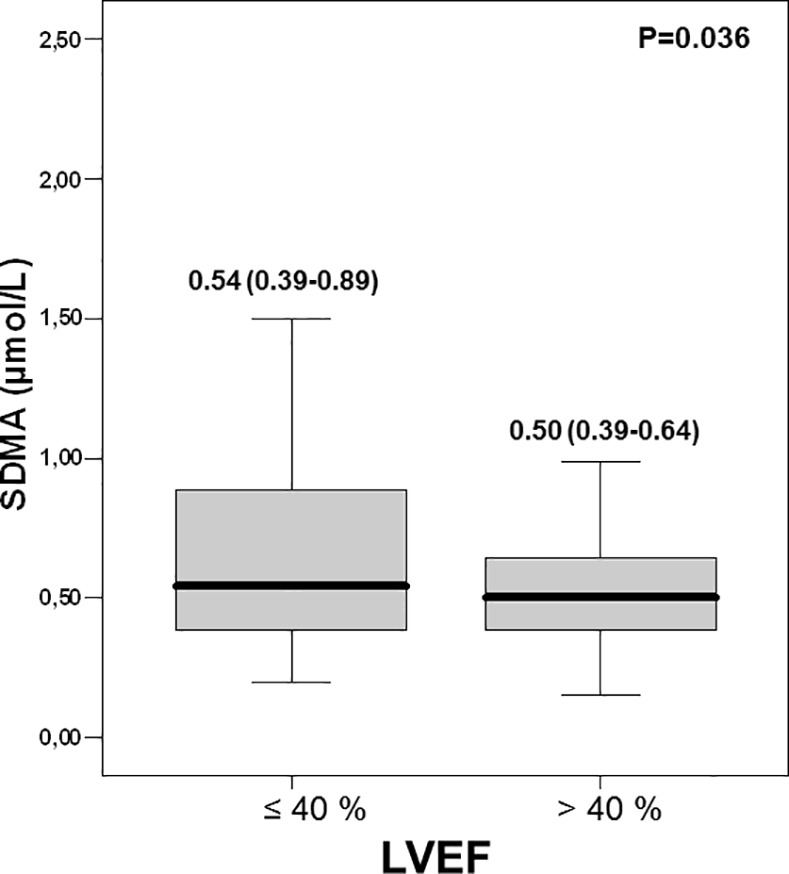
Symmetric dimethylarginine concentrations according to Left Ventricular Ejection Fraction (p value for comparison between the 2 groups).